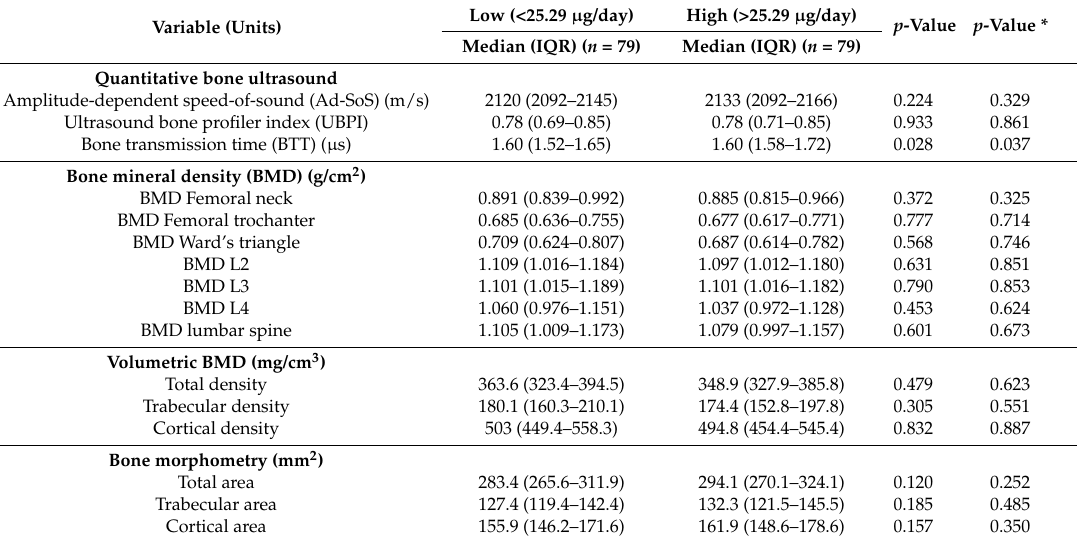
Table 4. Bone density and cadmium dietary intake in premenopausal women.